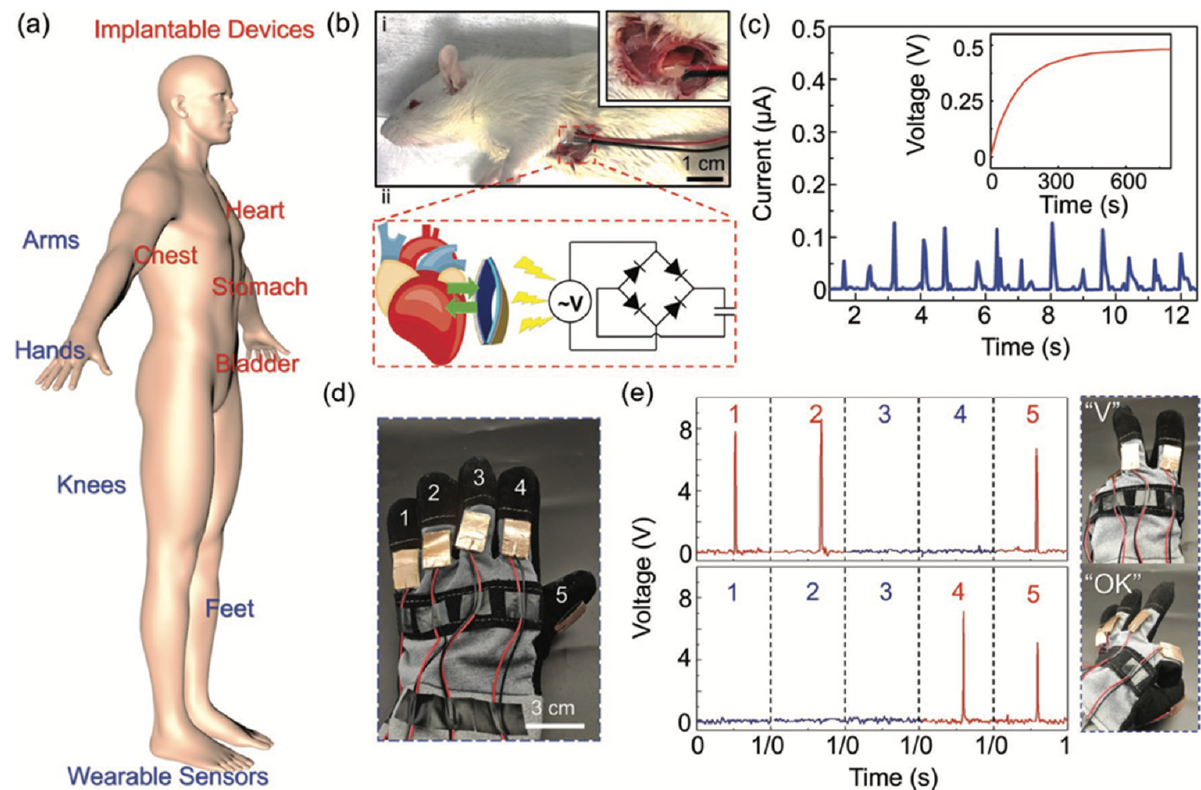
Figure 11. Potential applications of the hybrid nanogenerator proposed by Huang et al. [108]. ( a ) Schematic of a hybrid nanogenerator with potential applications in implantable devices and wear- able sensors. ( b ) (i) Photograph of a hybrid nanogenerator placed in the subdermal chest of a Spra- gue-Dawley rat; (ii) Schematic of the working mechanism of the nanogenerator for energy harvest- ing from a beating rat heart. For this, a rectifier circuit and a capacitor (4.7 μF) were implemented. ( c ) Current signals of an implanted hybrid nanogenerator related to the beating heart. Inset shows the storage voltage of a capacitor (4.7 μF). ( d ) Photograph of a hybrid nanogenerator adhered on the glove for hand-gesture monitoring. ( e ) Output voltage signals of nanogenerators placed on the five fingers for “Victory” and “OK” hand gestures. Reprinted with permission from [108]. Copyright